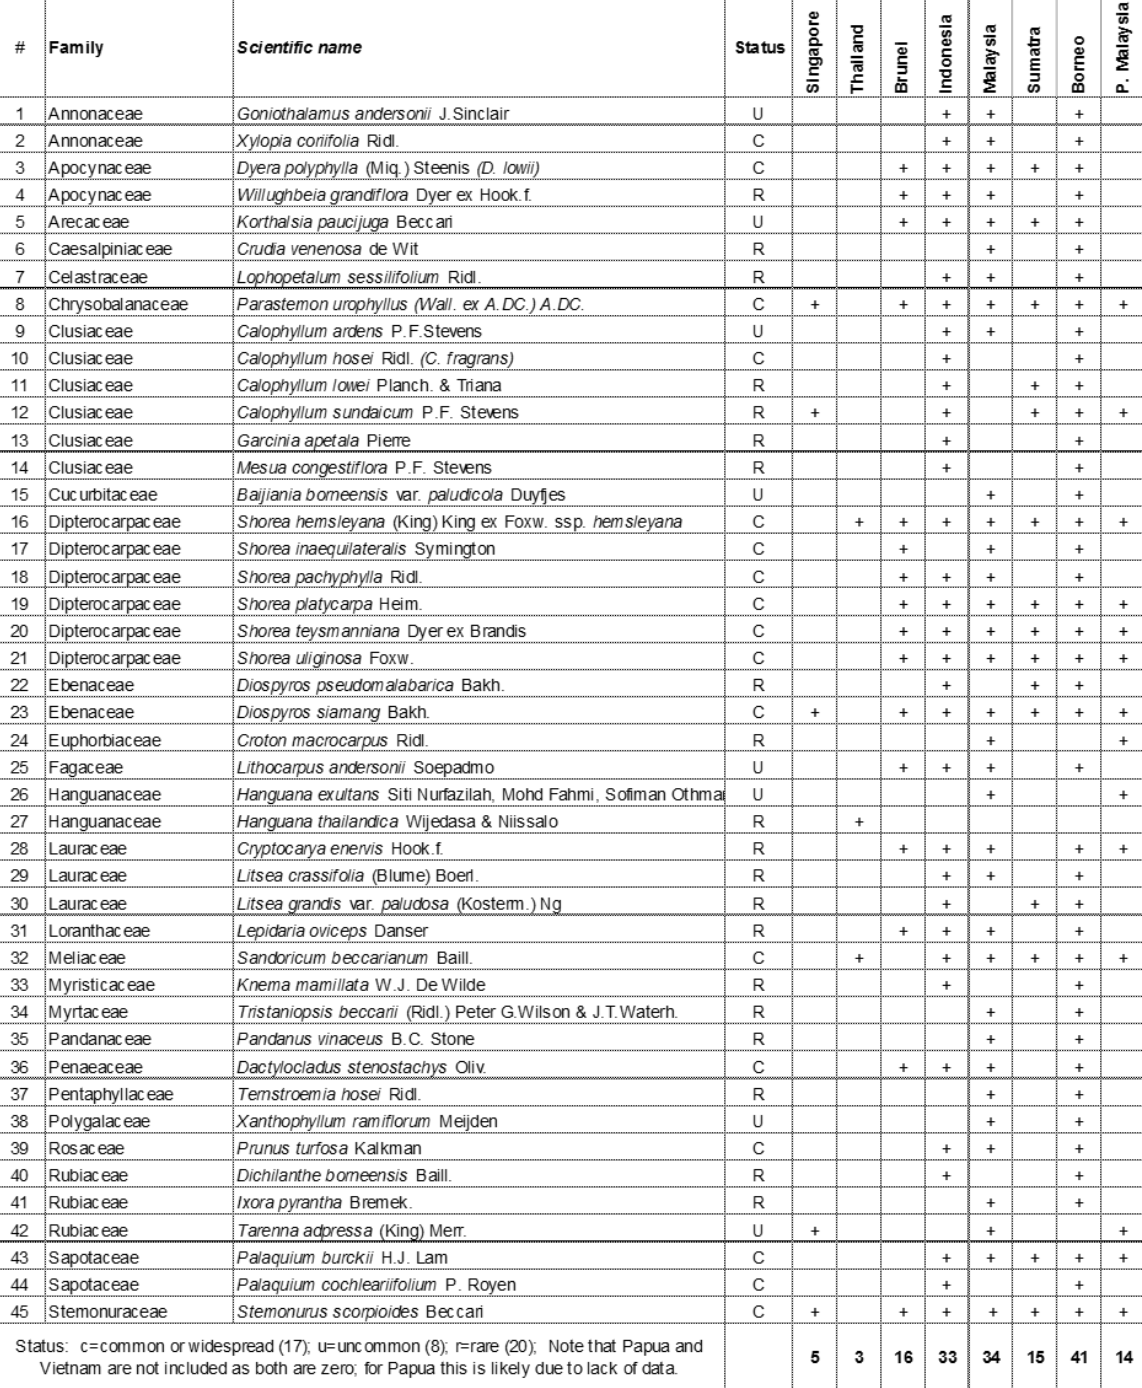
Table 2. Plant species restricted to peat swamp forests in Southeast